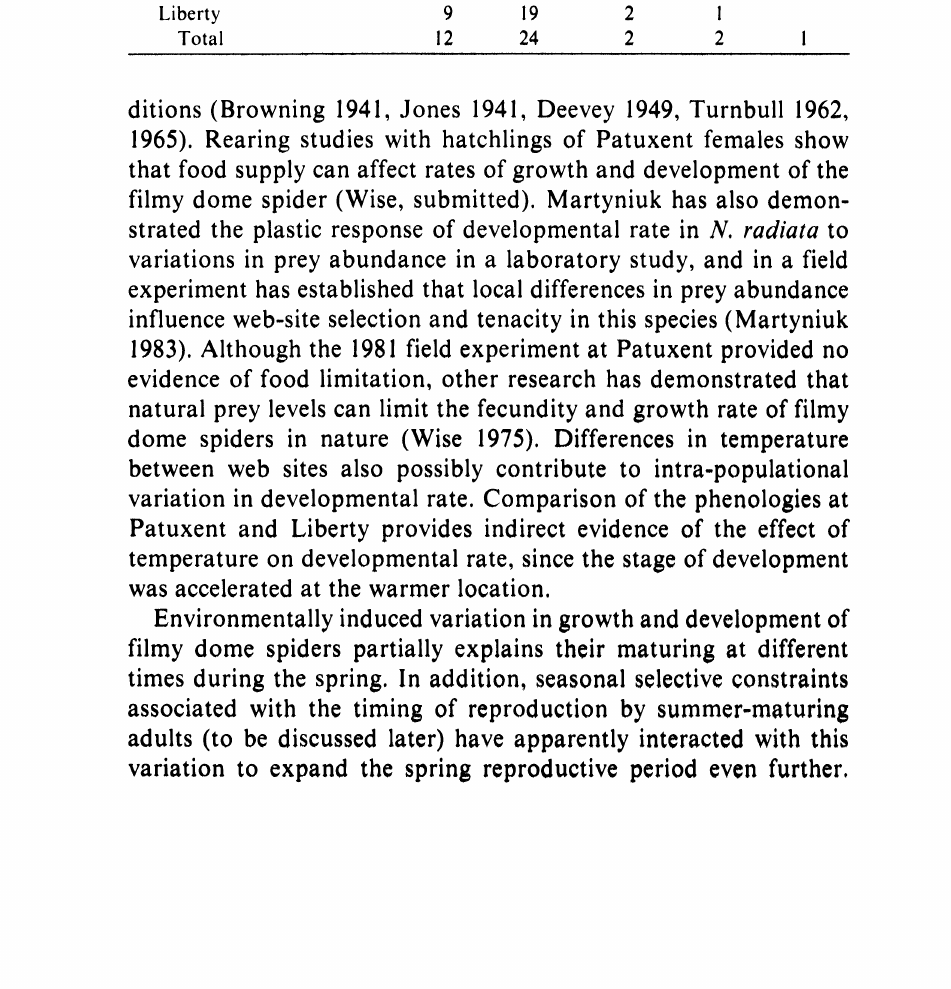
Table 4. Estimated stages, when collected from natural populations on 21 July 1982, of spiders that were alive as immatures in mid-September or that had matured by then. Stages were estimated by comparing tibia lengths to a distribution derived from a previous laboratory rearing study (unpubl). A. Numbers in each stage on 21 July that had matured. B. Numbers in each stage on 21 July that were immature and alive in September. All spiders that matured before winter had done so by